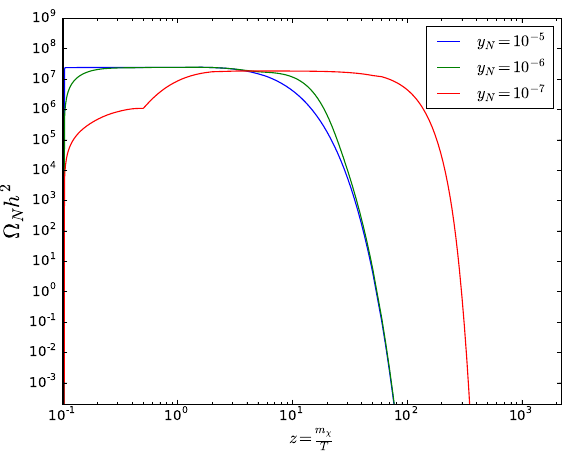
Figure 4 . The thermal evolution of the sterile neutrino, in the case of three di(cid:11)erent y N . We should note that the y N = 10 (cid:0) 5 curve is very close to the equilibrium case, besides the very sharp \jumping up" at the